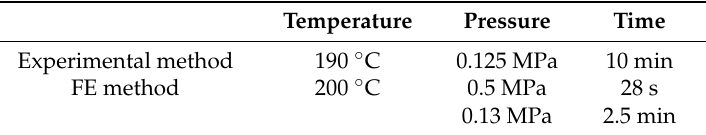
Table 2. Processing methods for the composite